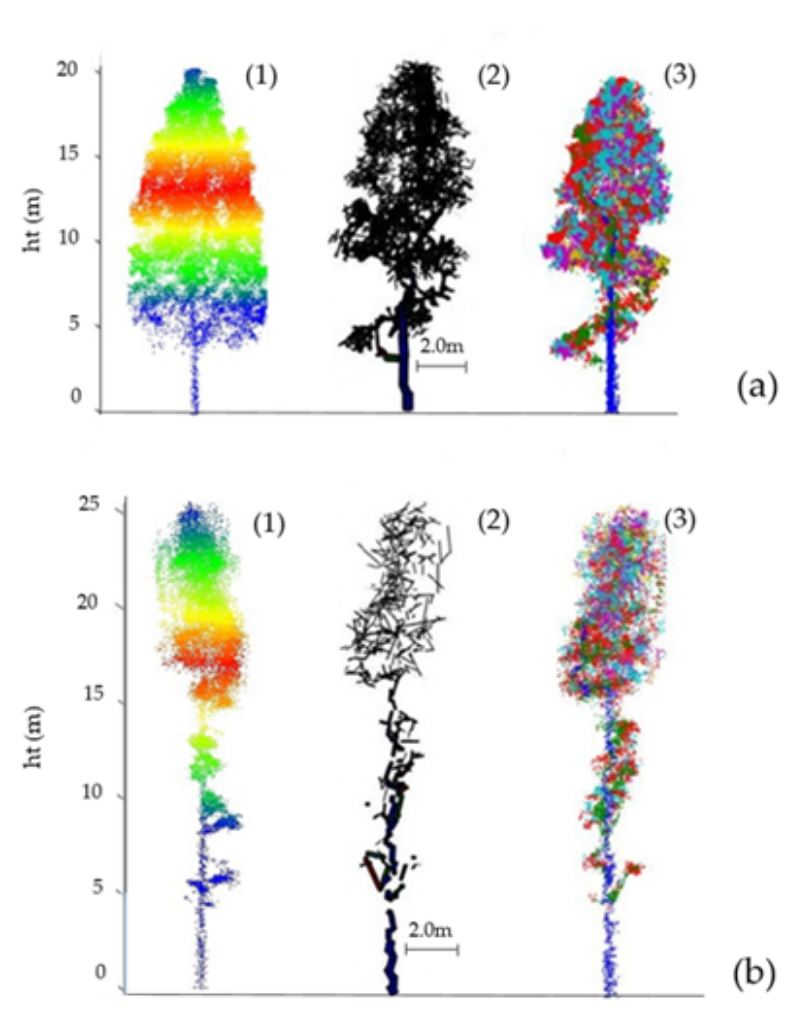
Figure 6. Contrasting density of points in the representation of tree architecture: ( a ) Example of a tree with satisfactory point density; ( b ) Example of a tree with lower point density. (1) Tree point cloud; (2) Structure model of the tree; (3) Automatically reconstructed tree